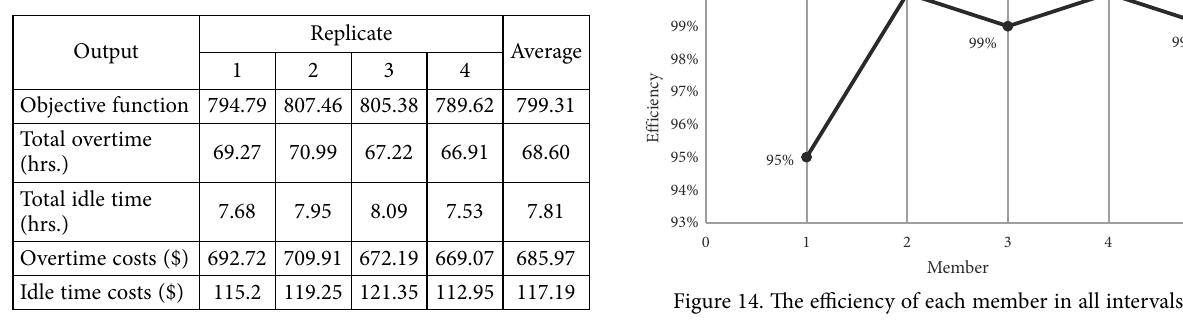
Table 11. The values of objective functions